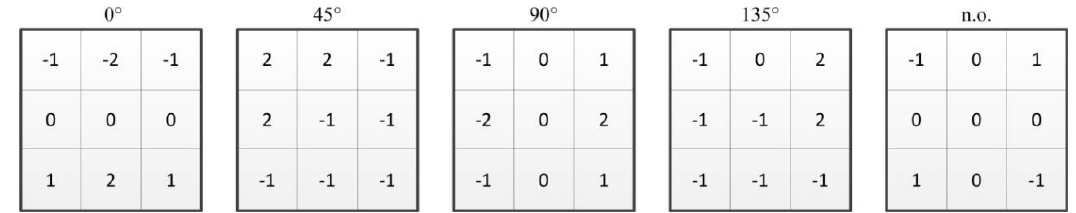
Figure 3. Sobel filters of five orientations at 0°, 45°, 90°, and 135° and no orientation.